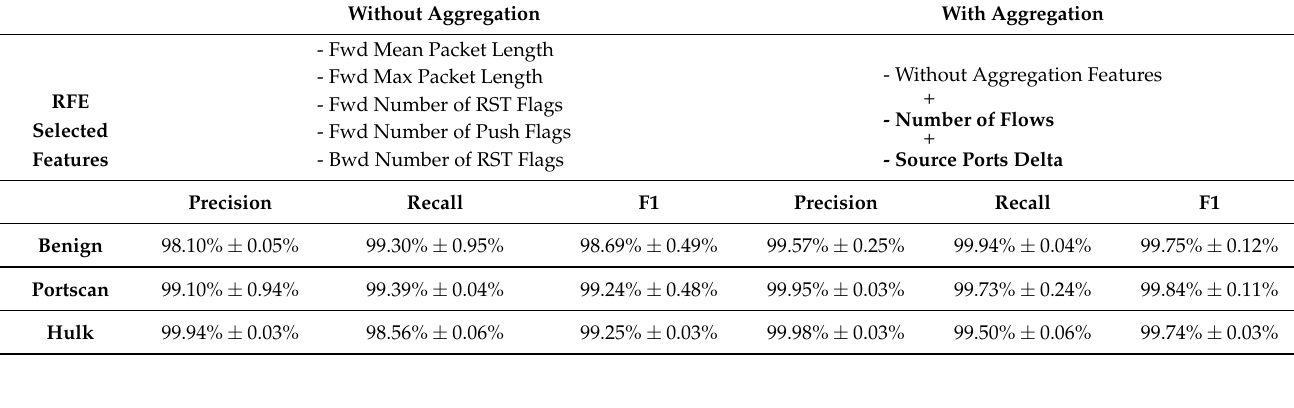
Table 10. Benign vs. PortScan vs. DoS Hulk classification (5-fold cross validation).